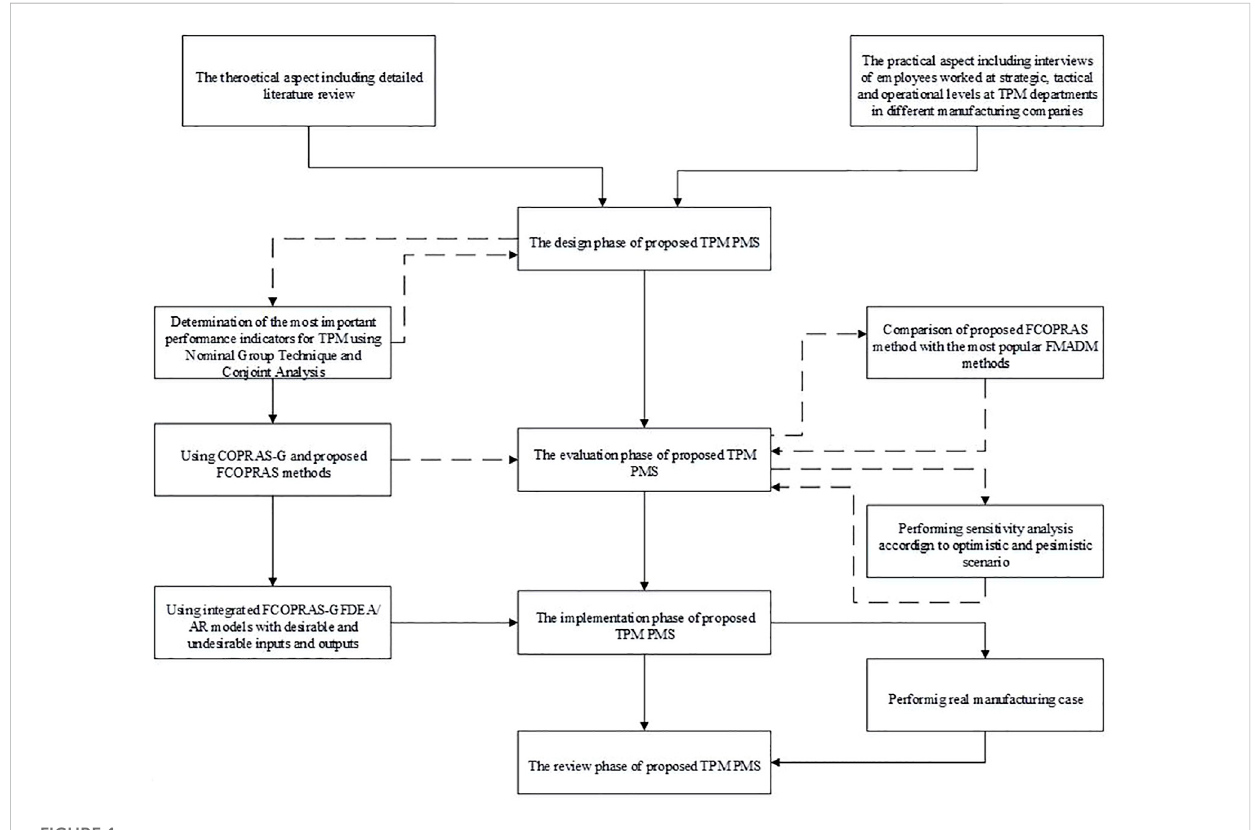
FIGURE 1 The general overview of the proposed TPM